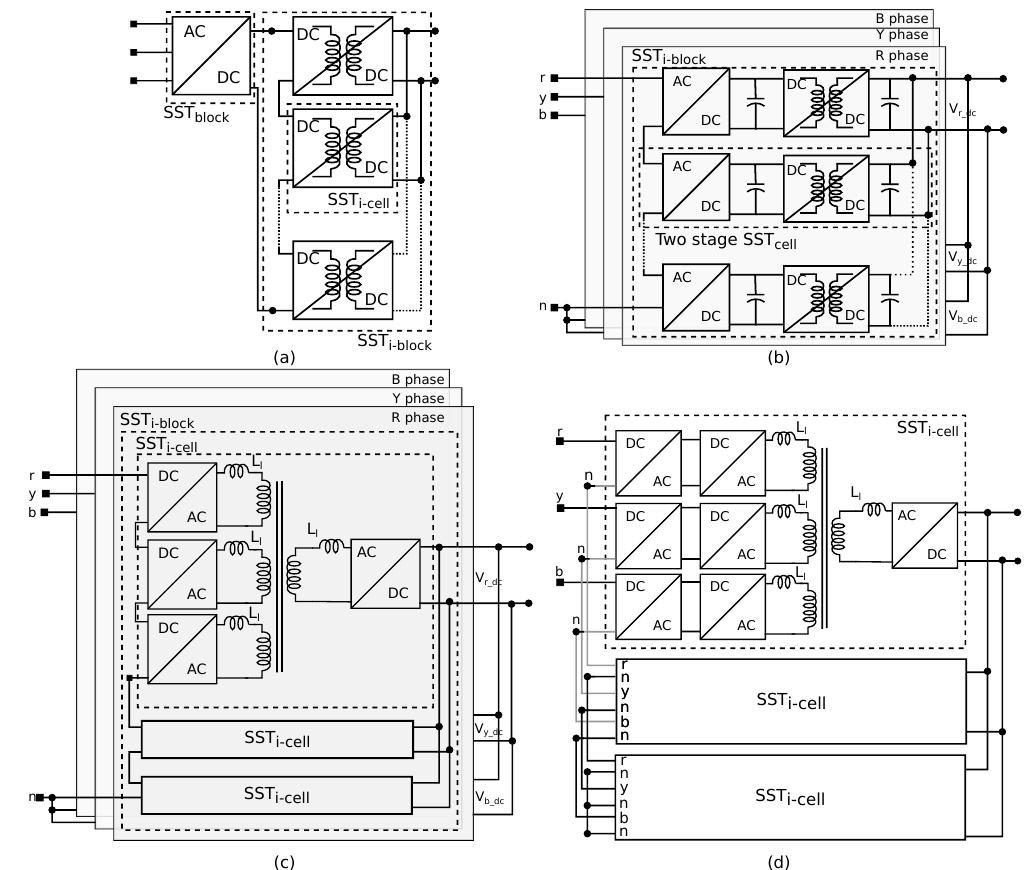
Figure 22. Phase modular SSTs presented in [19,55,77,94]: ( a ) using front end MMC and back end DAB in ISOP, ( b ) CHB with DAB in ISOP configuration, ( c ) QAB in ISOP configuration, and ( d ) interphase QAB in ISOP